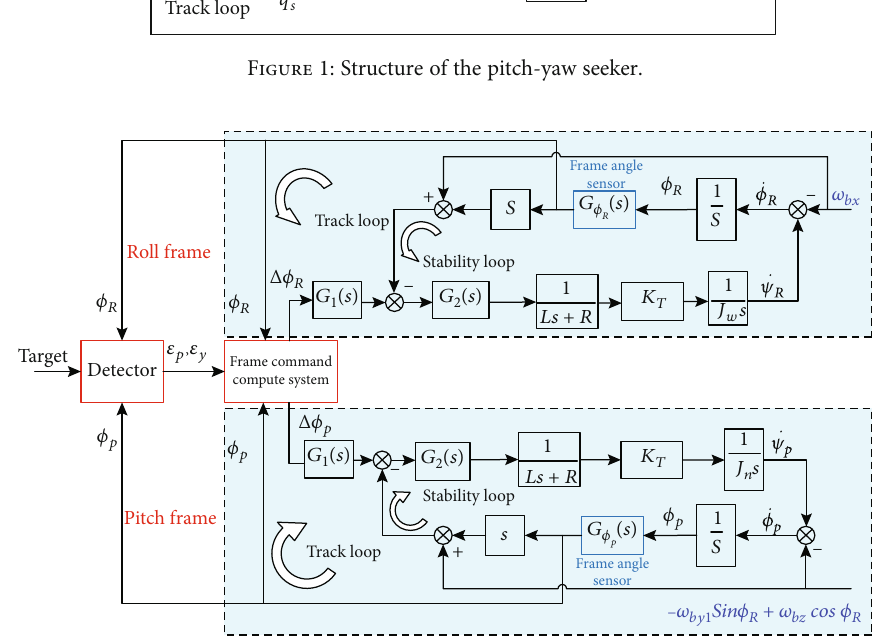
Figure 2: Model of the roll-pitch